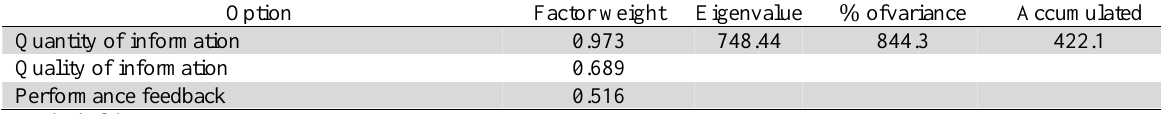
The summary of factors associated with content information